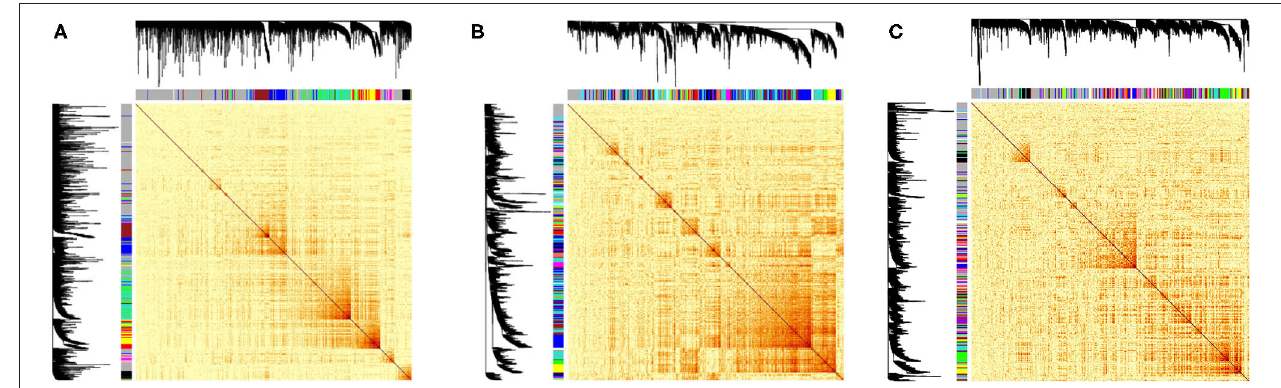
FIGURE 3 | Heatmaps of the correlations between lncRNAs-mRNAs with their corresponding cluster dendrograms of the datasets. The colors below the dendrogram indicate the clusters. (A) NAT tissue TCGA-LIHC project, (B) HCC tissue TCGA-LIHC project, and (C) Liver tissues from GTEx